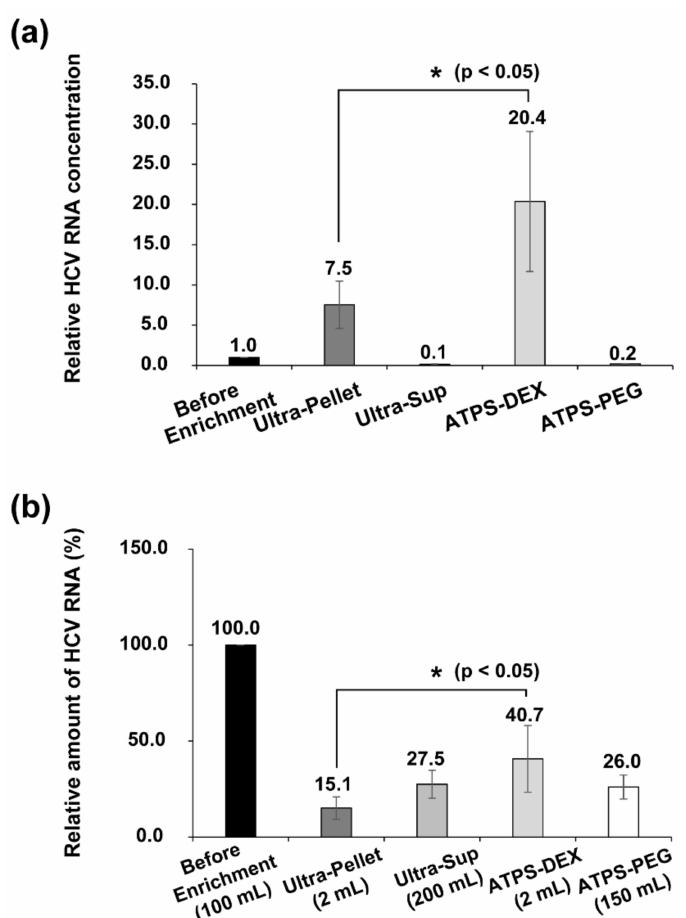
Figure 3. Efficacies of the hepatitis C virus (HCV) RNA enrichments by ultracentrifugation and the aqueous two-phase system (ATPS). The HCV (JC1-E2-Flag variant) RNAs in samples before and after enrichment processes (ultracentrifugation and ATPS) were quantified using quantitative reverse transcription polymerase chain reaction. ( a ) The relative concentrations of HCV RNAs in solutions before and after enrichment are depicted. ( b ) The recovery rates of the enrichment processes were calculated as described in the Materials and Methods. The columns and bars represent the means and standard deviations, respectively. The average value is depicted on the top of each column. p values less than 0.05 are indicated by one asterisk (*). Experiments were performed three times. ATPS-DEX: ATPS dextran layer; ATPS-PEG: ATPS polyethylene glycol (PEG) layer.